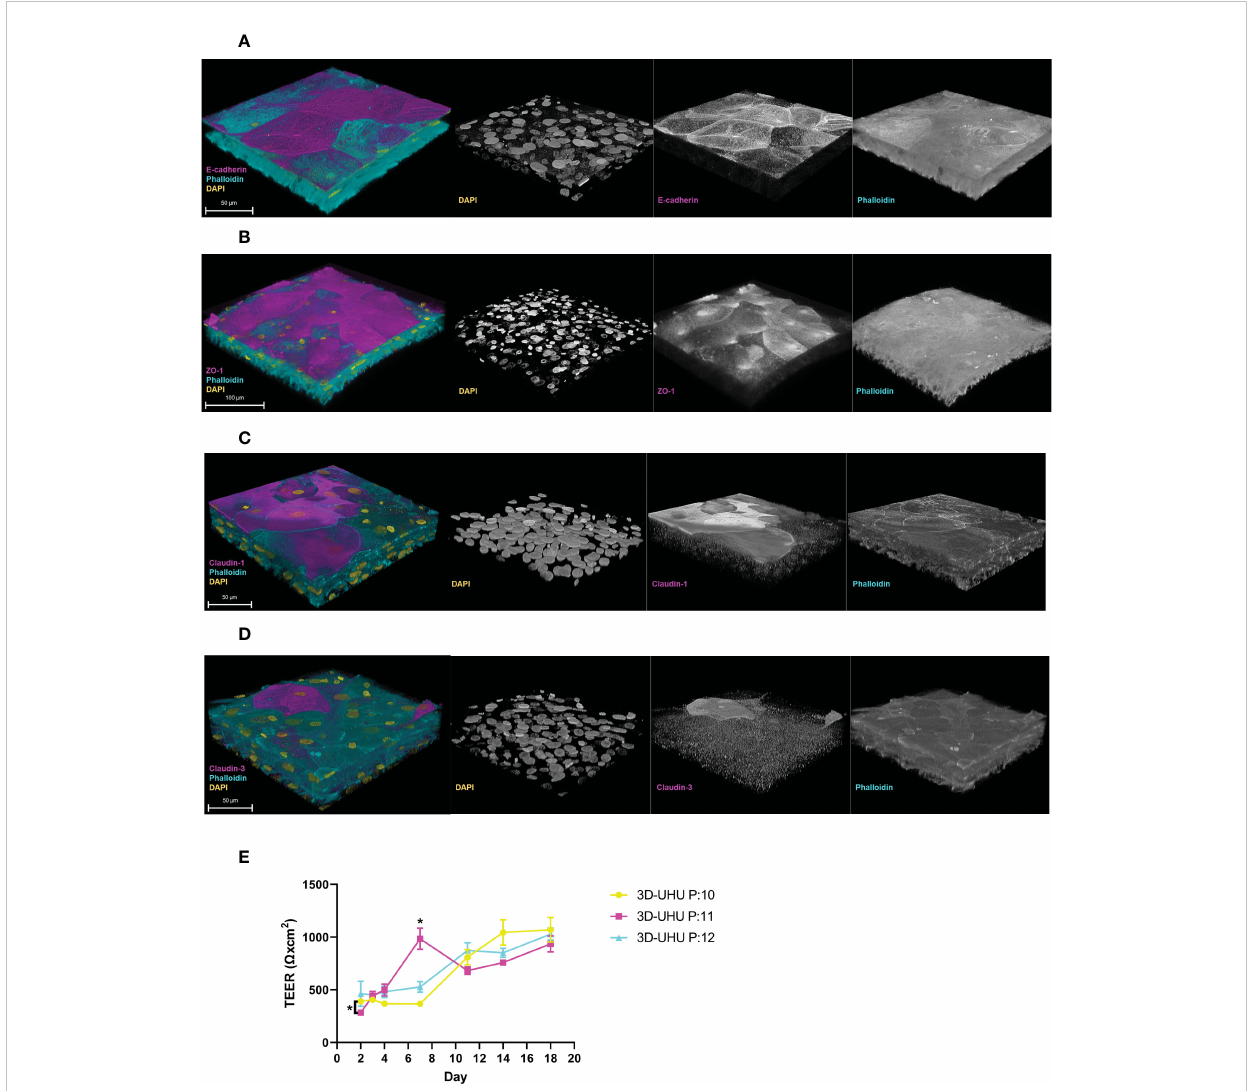
FIGURE 5 The 3D-UHU model expresses adherens and tight junction proteins and forms a barrier. (A, B) 3D confocal image of urothelial model expressing E- cadherin and ZO-1, respectively at the apical surface (magenta); (C, D) claudin 1 and claudin 3 presented throughout the layers (magenta). Phalloidin-stained F-actin is presented in cyan and DAPI-stained DNA is presented in yellow; scale bars are as shown. Images are representative of at least three biologically independent experiments. (E) TEER measurement of 3D-UHU model in a time-dependent manner on models from three different passages (P:10-12); * p < 0.05 calculated by two-way ANOVA followed by Tukey ’ s multiple comparisons test; data represent mean ± SD, n=3 biologically independent